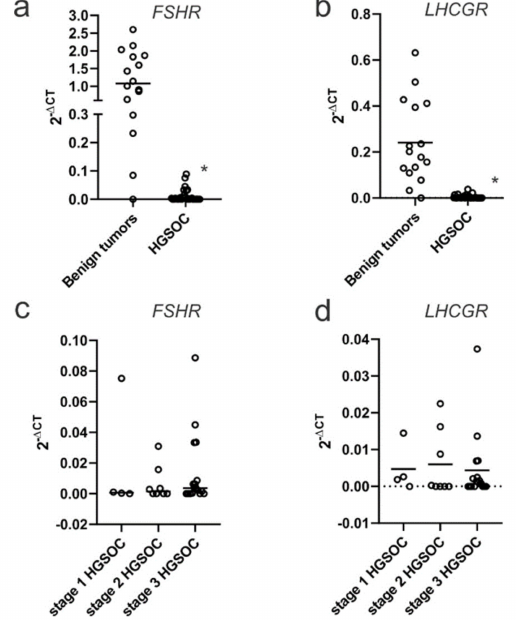
Figure 2. FSHR and LHCGR mRNA expression is reduced in high grade serous ovarian carcinoma (HGSOC) compared to benign serous ovarian tumors: ( a ) FSHR in benign ovarian tumor ( n = 17) and HGSOC ( n = 29); ( b ) LHCGR expression in benign ovarian tumors ( n = 17) and HGSOC ( n = 29). ( c ) FSHR expression in FIGO stage I ( n = 4), FIGO II ( n = 8) and FIGO III ( n = 17) HGSOC. ( d ) LHCGR expression in stage I ( n = 4), II ( n = 8) and III ( n = 17) HGSOC. * p < 0.05, Mann–Whitney U test. Circles are data from each